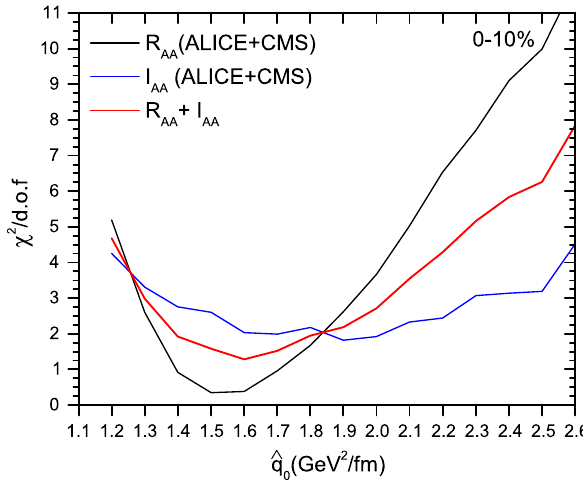
Fig. 5 Global χ 2 analysis for single hadron and (or) dihadron nuclear suppression factors in Pb+Pb collisions at